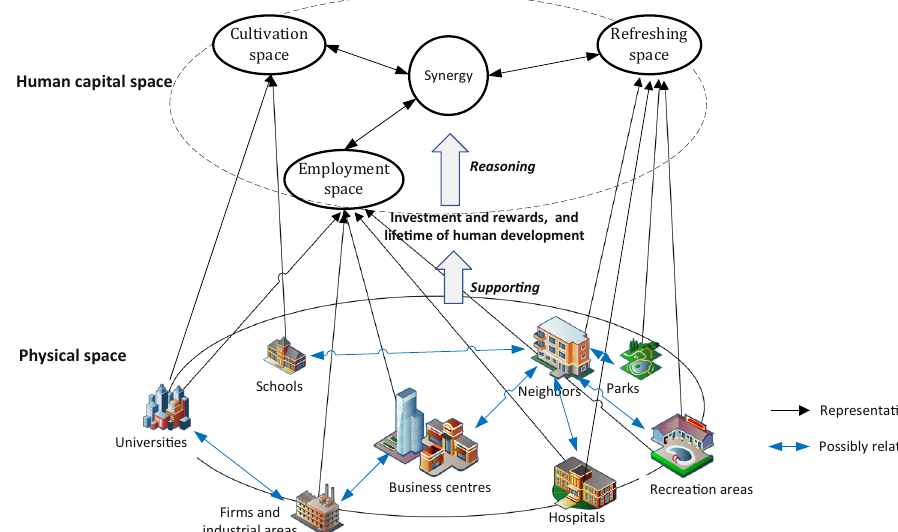
Fig. 2 Human capital space: Linking human and spatial development. The three types of human capital spaces (HCSs) are illustrated by physical entities. Their synergies can be explained by the reciprocity of investment and rewards during the lifetime of human development. Through the projection of HCS in physical spaces and complex relations among physical entities, HCS explains human-centred spatial